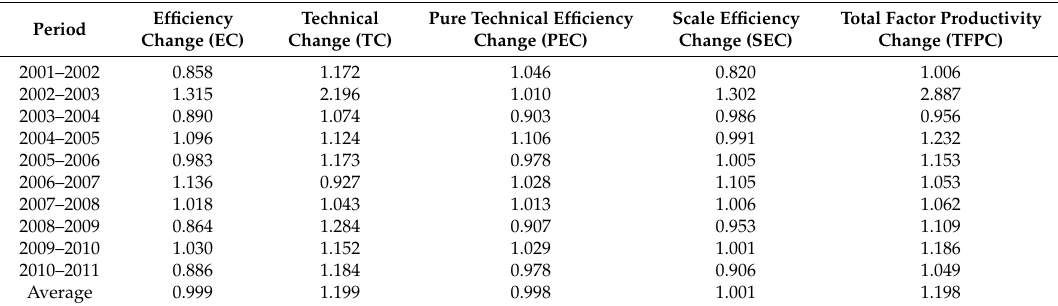
Table 2. Total factor productivity (TFP) variation of Chinese key state-owned forestry enterprises with